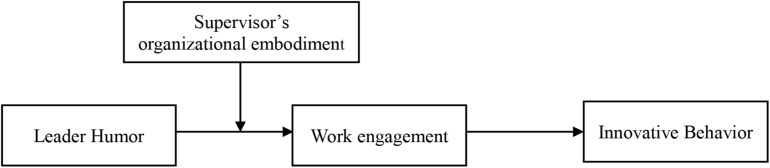
Theoretical model.